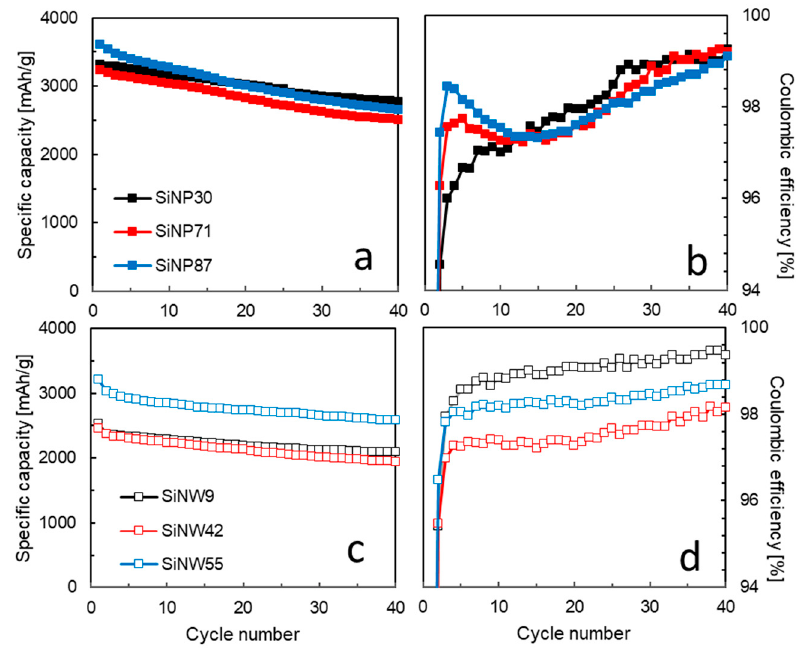
Figure 5. Electrochemical performance of SiNPs and SiNWs measured in half ‐ cell configuration at C/20 rate (activation), then C/5. Specific charge capacity (mAh per gram of silicon) as a function of the cycle number obtained from ( a ) SiNP and ( c ) SiNW electrodes. Corresponding Coulombic efficiency for ( b ) SiNP and ( d ) SiNW electrodes. The results presented here are the most representative of at least 3 repeatable cells (standard deviation 10%). Data for all SiNP sizes are available in Figure S5.